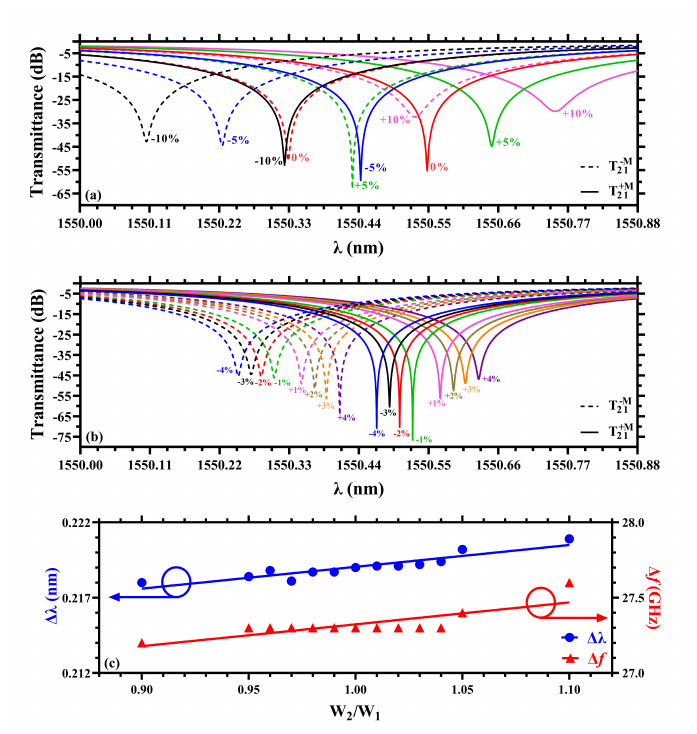
Figure 4. Resonances for ± M with small differences between the widths W 2 and W 1 . ( a ) Variations with steps of ± 5% from 0% to ± 10% and ( b ) variation from − 4 to + 4% with steps of 1%. ( c ) A linear fitting of ∆ λ as function of W 2 / W 1